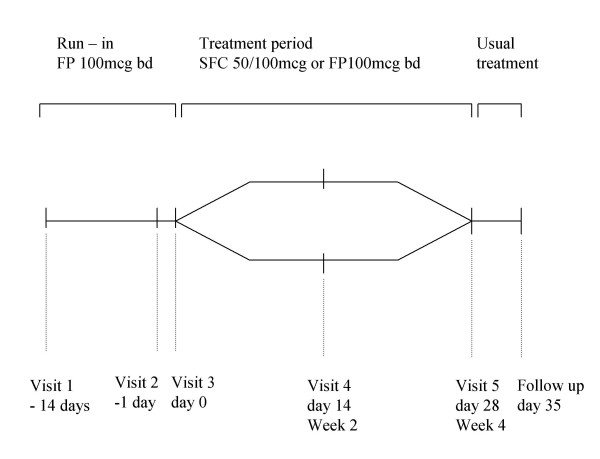
Study flow chart.